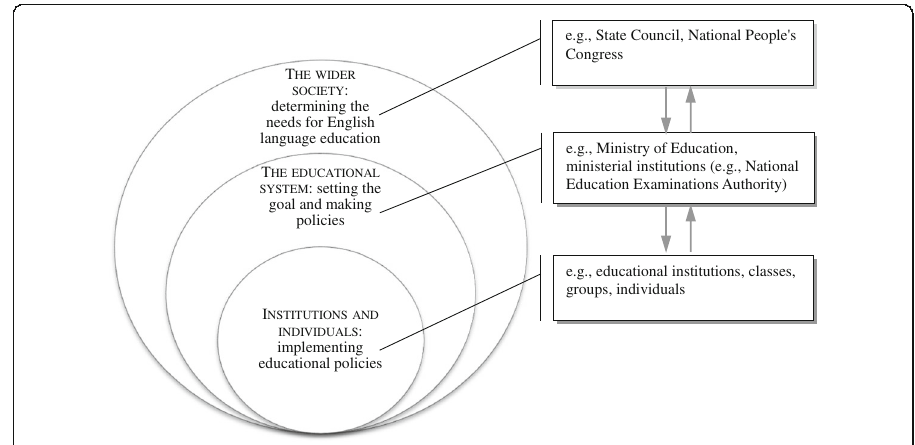
Fig. 2 English language education in China: the multilayered